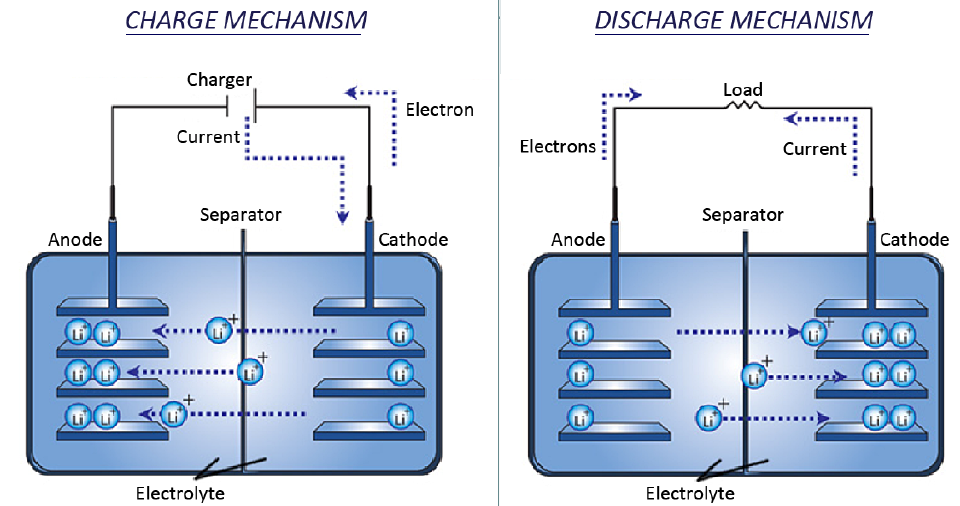
Figure 1. Charge and discharge process of secondary lithium-ion batteries